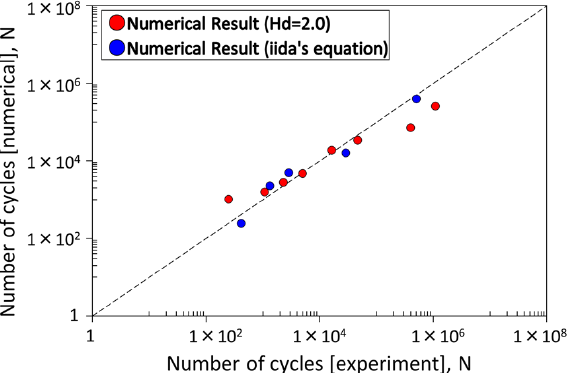
Figure 14. The experimental versus the numerical predicted number of cycles to crack initiation under the same loading conditions.